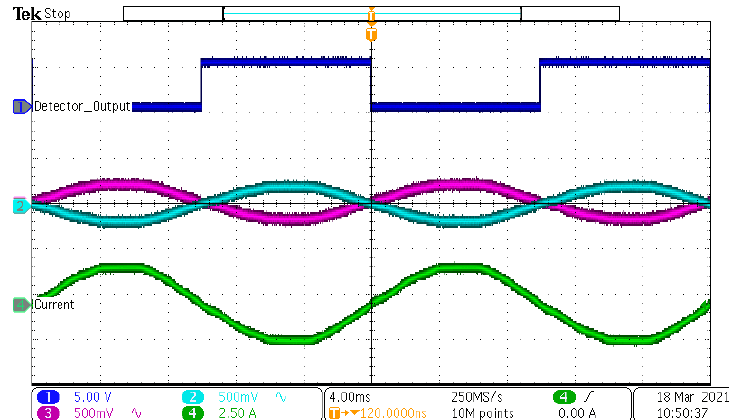
Figure 17. Current direction detection measurement (Blue, Current direction detector output 5 V/div; Green, Module current 2.5 A/div; Purple and Cyan, Differential outputs 500 mV/div).